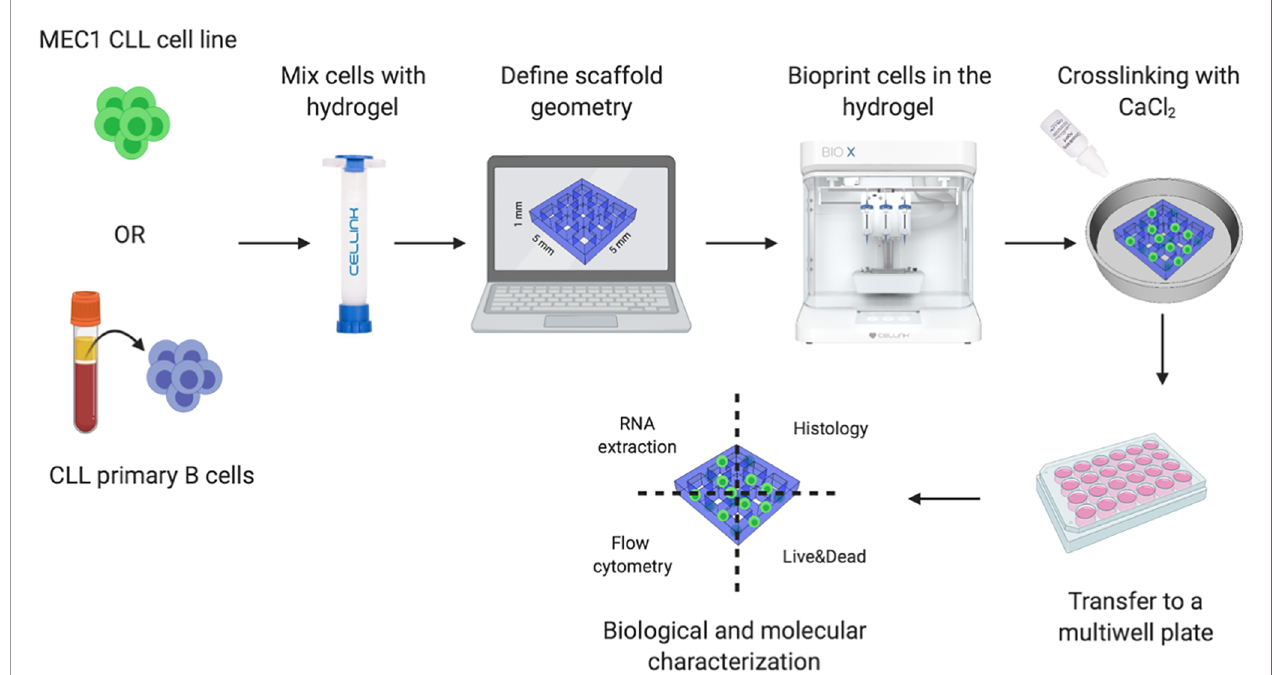
FIGURE 1 | 3D bioprinting strategy. Schematic representation of our 3D bioprinting strategy: CLL cell line MEC1 or CLL primary B cells were used. The cells are pre-mixed with hydrogels speci fi cally designed to support cellular adhesion and functions, as well as high printability and biocompatibility. Once the geometry of the